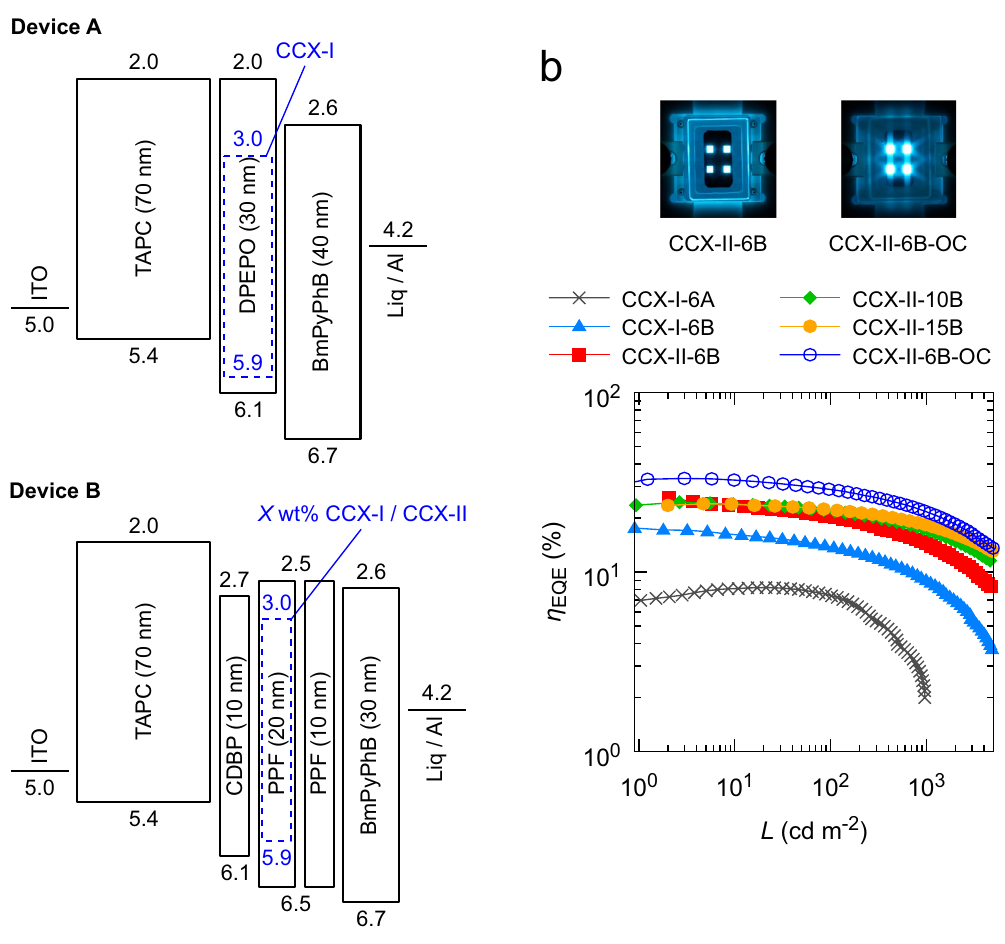
Figure 2. Energy level diagram of the materials for devices and their performance in OLEDs. ( a ) Energy level diagrams of the materials used in the devices. ( b ) η EQE - L characteristics and photos of CCX-II-6B and CCX-II-